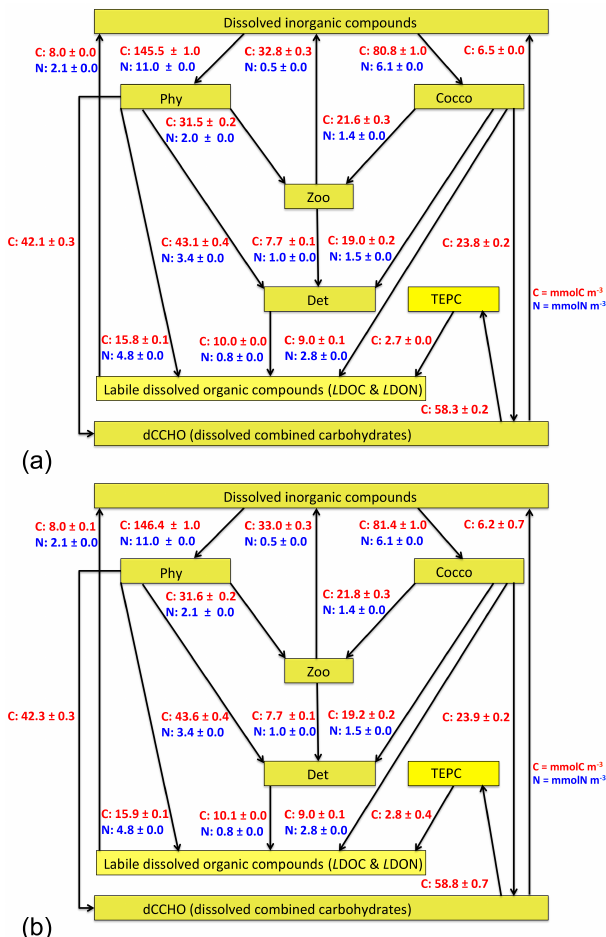
Figure 9. Carbon and nitrogen fluxes estimated by the model in mesocosms with low observed calcification but different CO 2 treat- ment, high (a) and low (b) . All the arrows that point downwards show flux estimates from the respective compartment on the right hand side, whereas arrows pointing upwards show values on the left hand